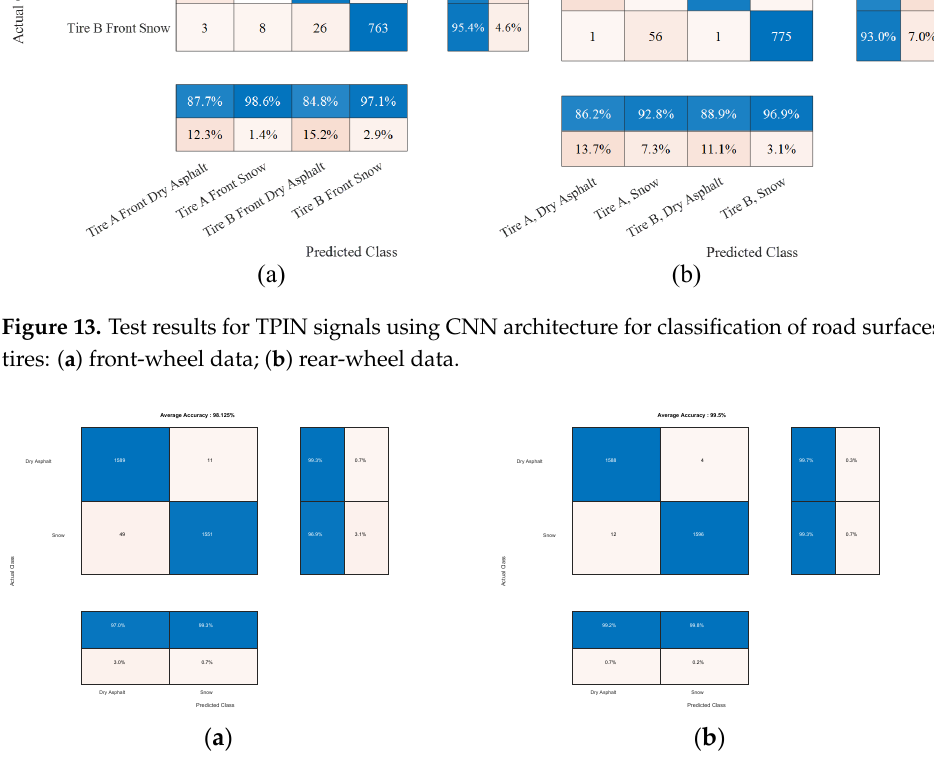
Figure 14. Test results for TPIN signals using CNN architecture for classification of road surfaces without splits of different tires are different: ( a ) front-wheel data; ( b ) rear-wheel data.